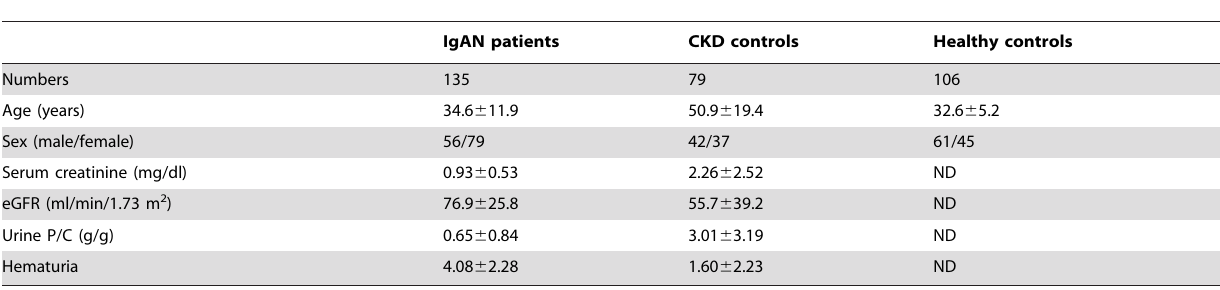
Table 2. Characteristics of patients with IgAN and CKD